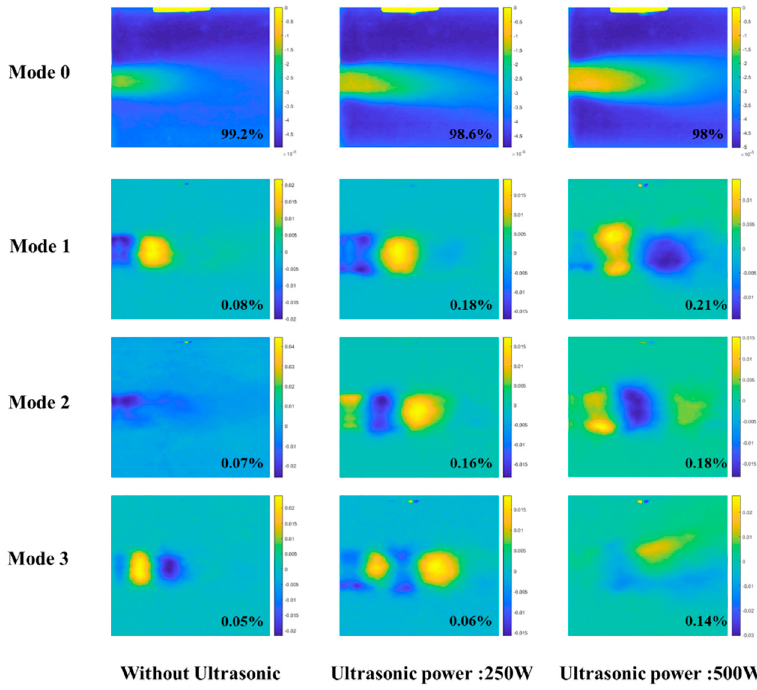
Figure 11. The first four modes are at different ultrasonic power.